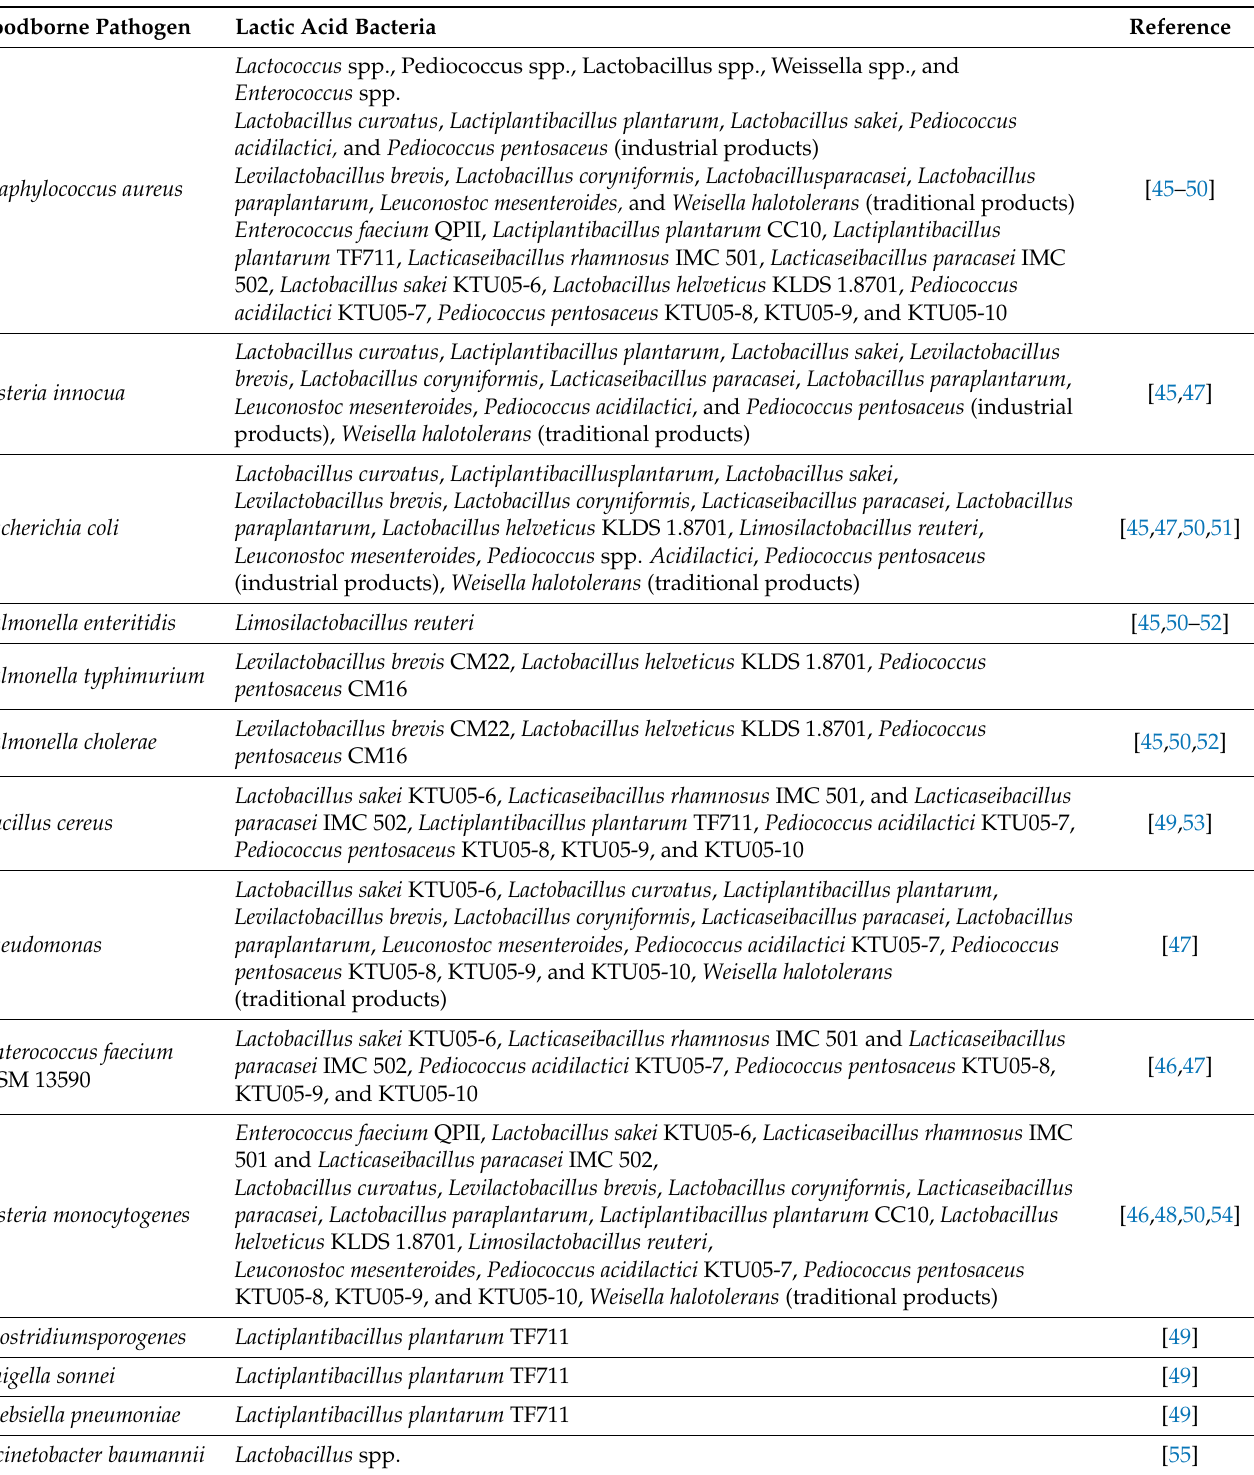
Table 4. Inhibition of food pathogens by lactic acid